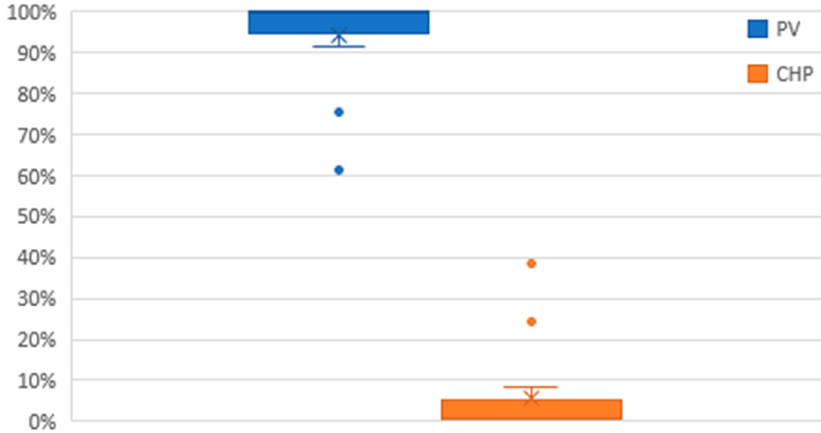
Figure 13. Box and whisker plot of the electrical production percentage by the PV modules and CHP unit.